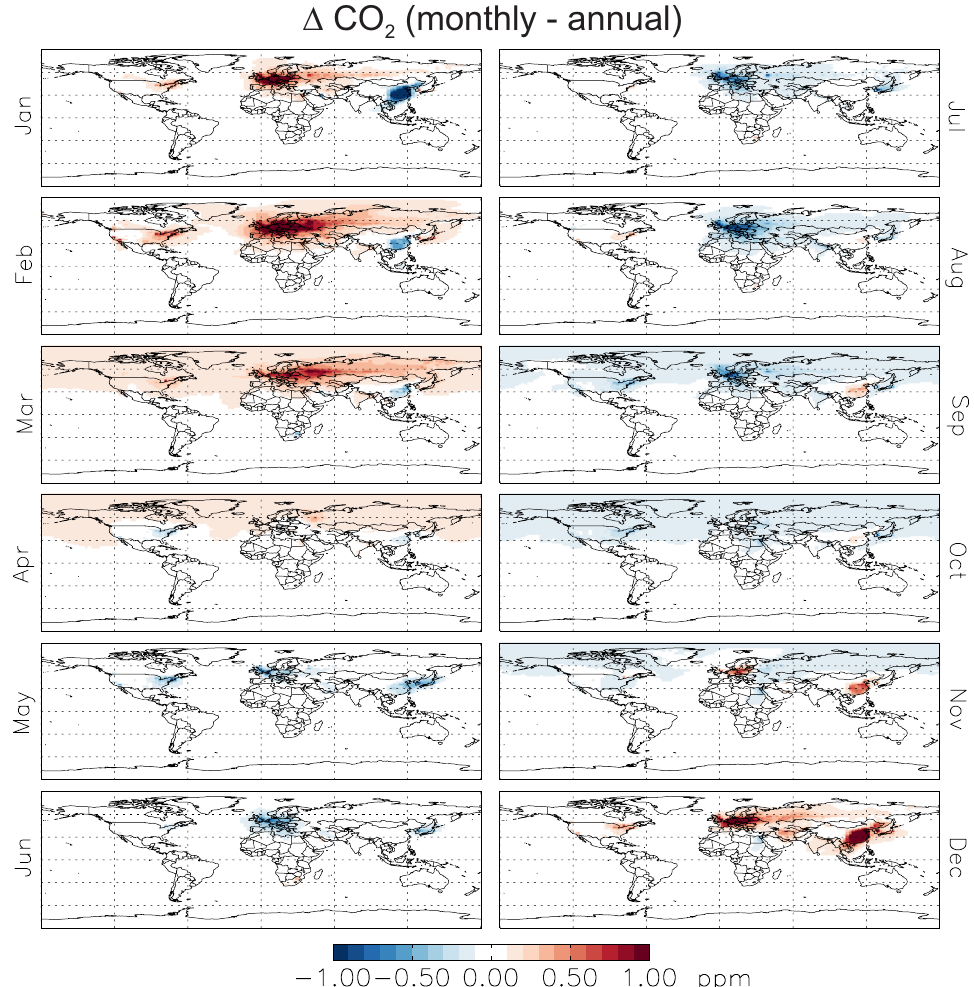
Fig. 1. Comparison of monthly-averaged surface level CO 2 in 2006 from a simulation using the monthly-varying fossil fuel emissions and another simulation using annual fossil fuel emissions with the same cumulative annual total. The simulations began with the same initial conditions for 1 January 2006 and were identical in all other